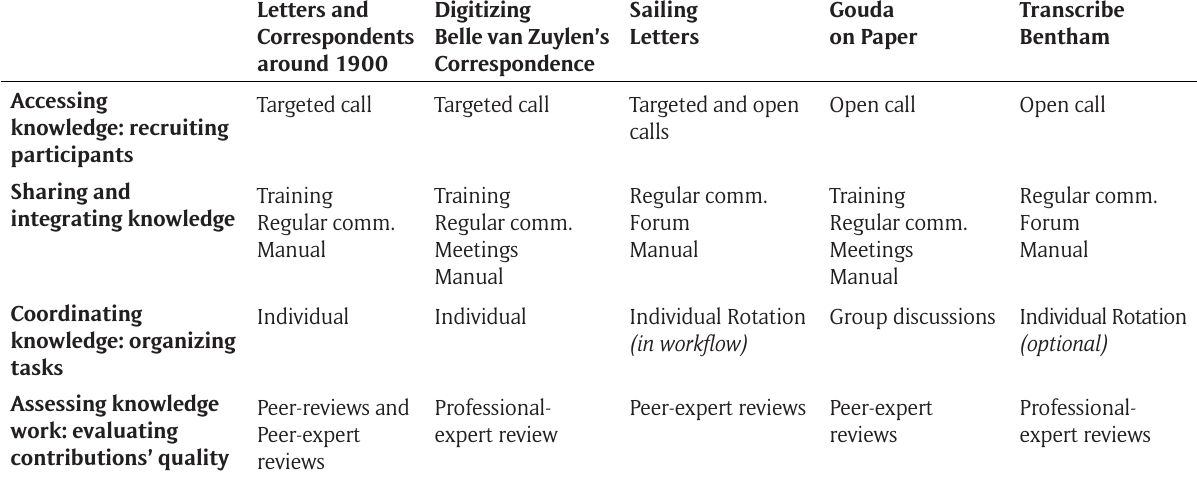
Table 3: Different configurations of knowledge management